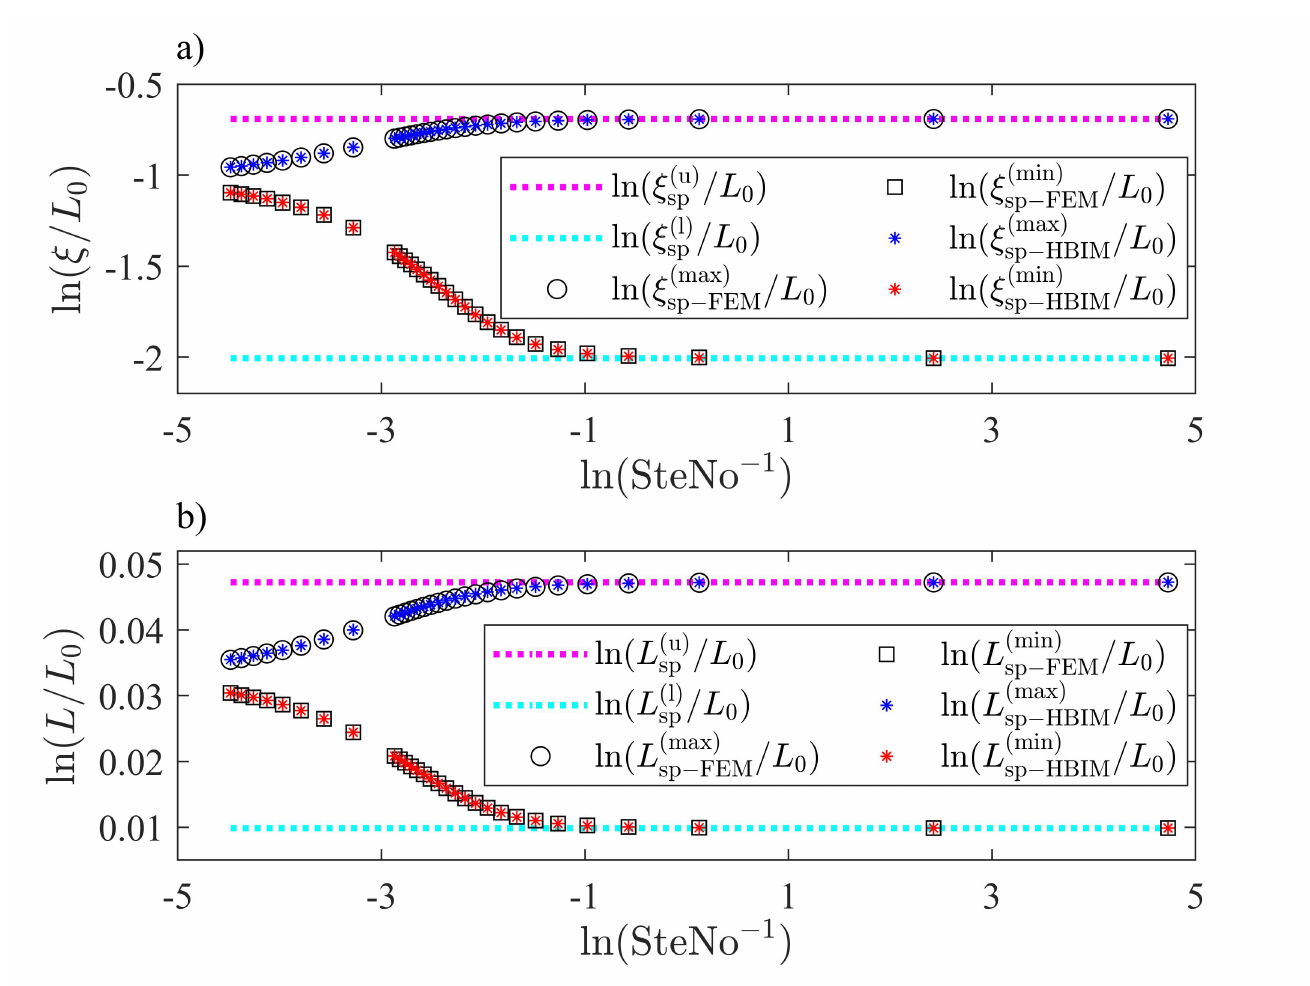
Figure 9. ( a ) HBIM and FEM steady periodic solutions as a function of the natural logarithm of the inverse Stefan number ln (cid:16) L ( max ) ( t ) / L 0 ln close to the steady periodic regime at t = 9